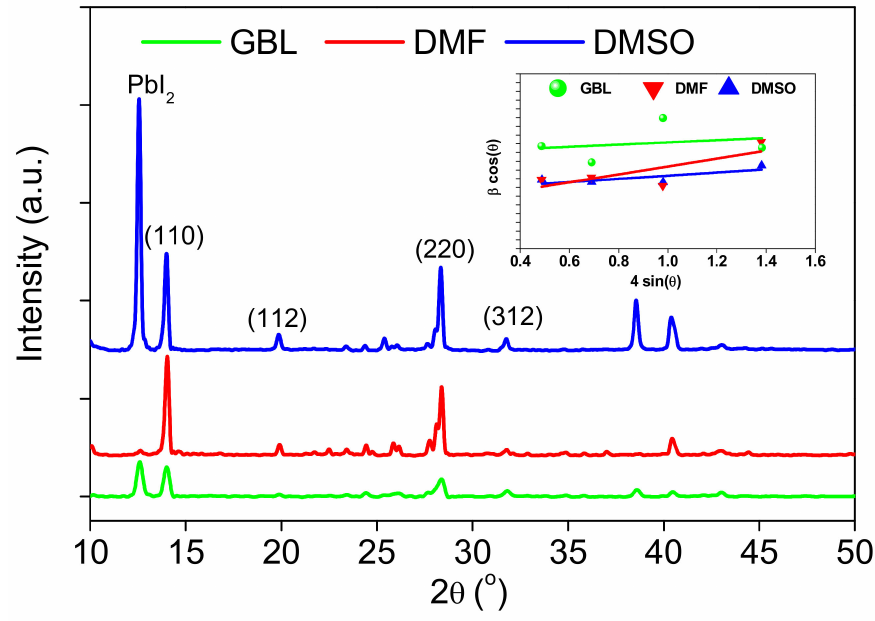
Figure 2. X-ray Diffraction patterns of the MAPbI 3 perovskite thin films were prepared using different solvents. The insets show a Uniform deformation mode plot which concluded from XRD